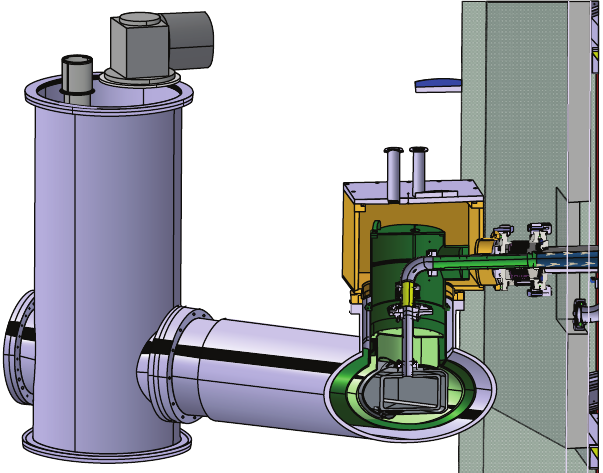
Figure 7: A successful cooldown in 100 hours. The temperature of several areas of the cryostat is constantly monitored. It takes 48 hours from the beginning to start 4 He liquefaction, which helps cooling the conversion volume. 48 hours later, the conversion volume is cold enough for keeping liquid 4 He. 52 additional hours are needed to fill in this volume. Then, He-II can be cooled down to the temperature of 0.74 K.